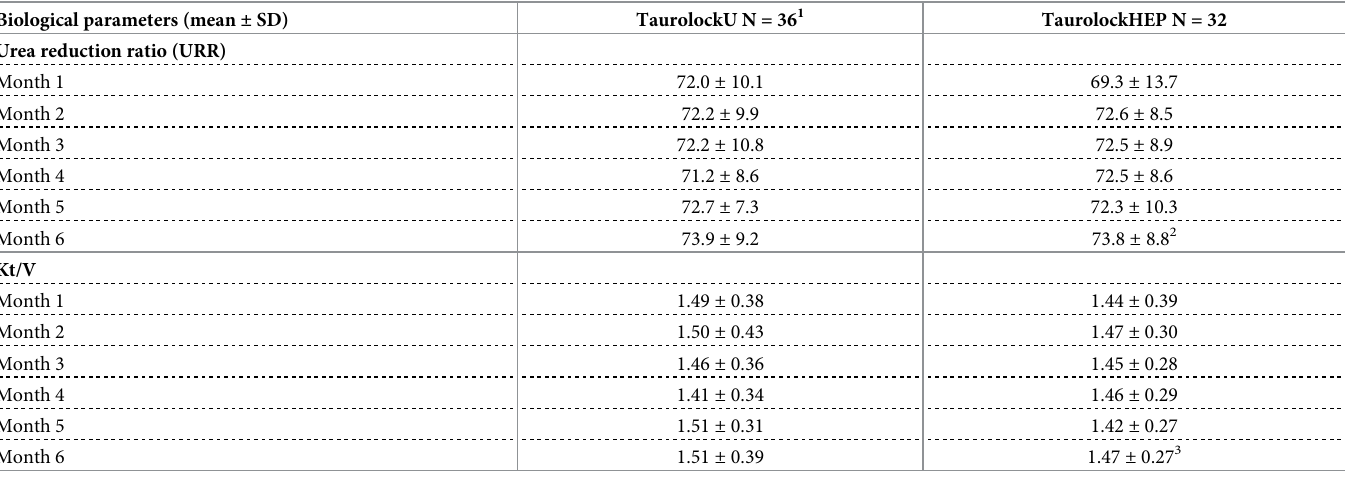
Table 5. Evolution of hemodialysis adequacy parameters during the 6-month study period. Biological parameters (mean ± SD)